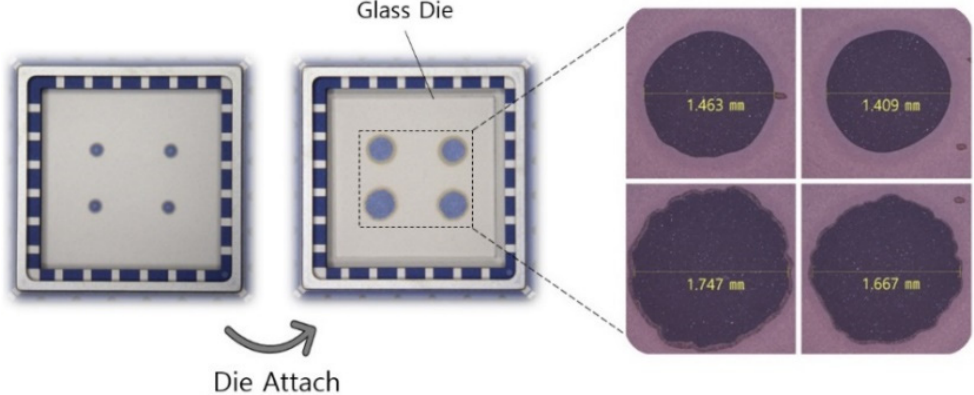
Figure 9. Die attach pattern and spreading shape of the die adhesive in the four-dots die attach.